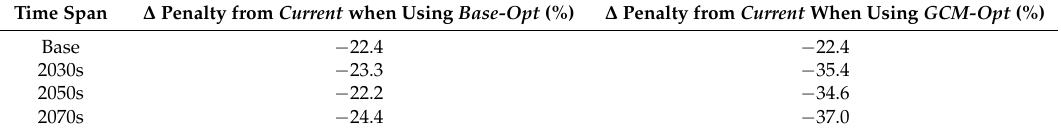
Table 4. Percent changes in penalty of optimized operating guides compared to the current operating guide.